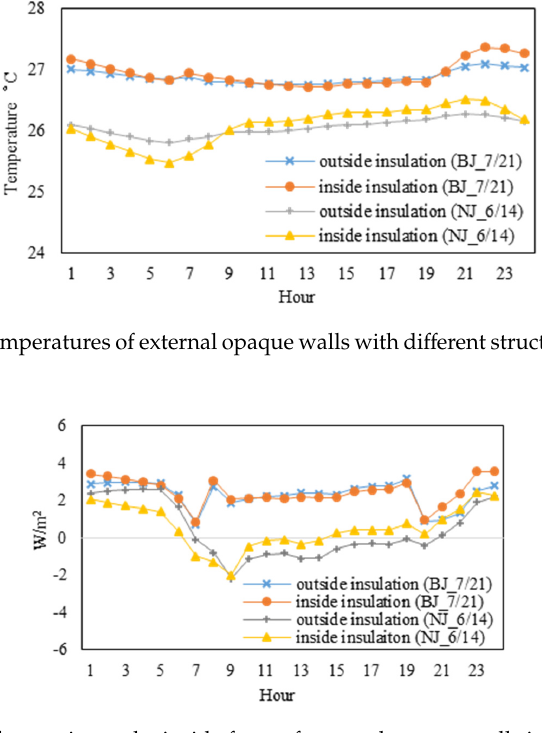
Figure 12. Conduction heat gains at the inside faces of external opaque walls in north perimeter zones with ESCS.